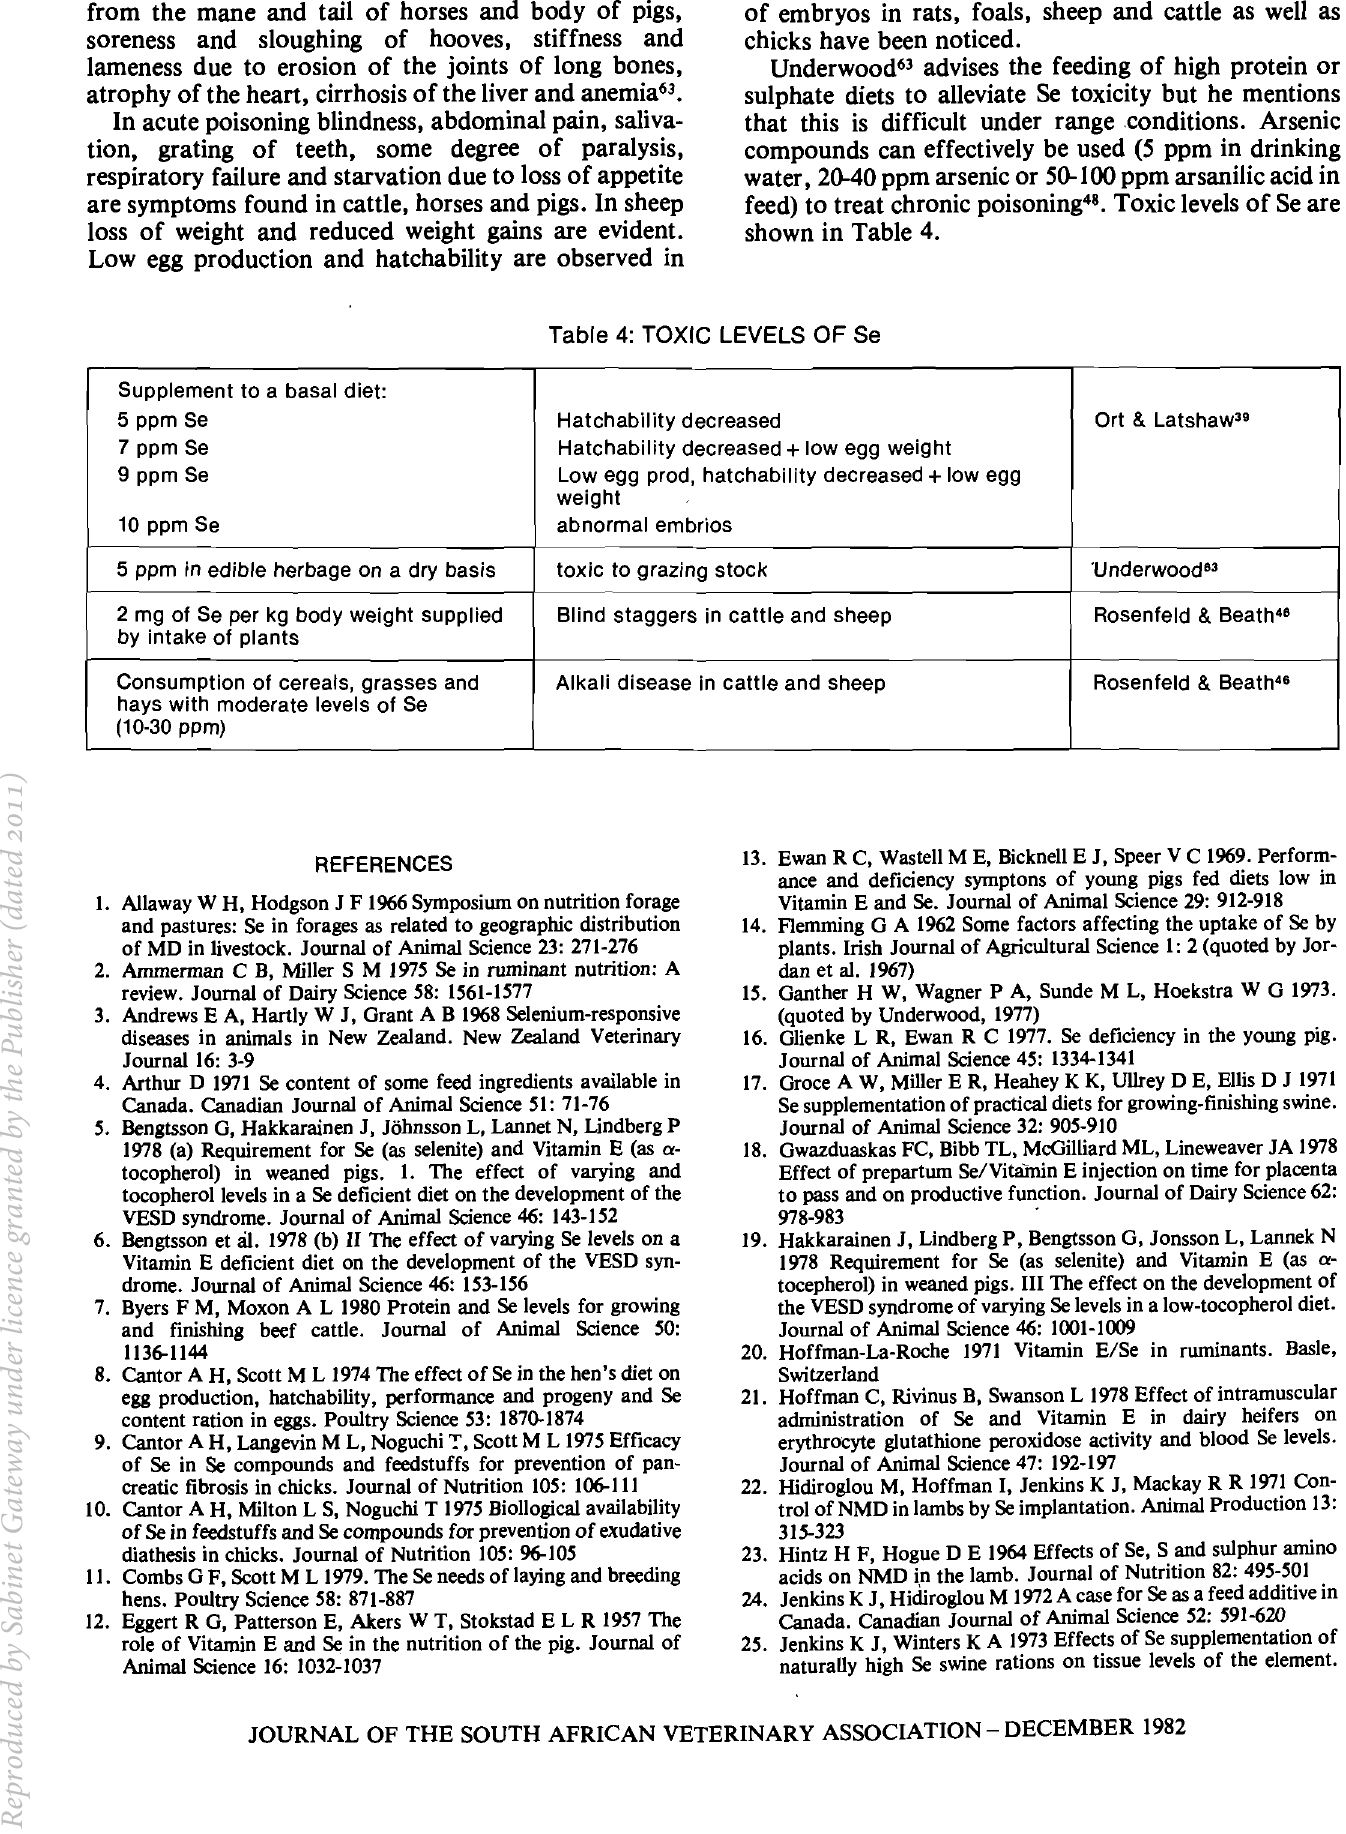
Table 4: TOXIC LEVELS OF